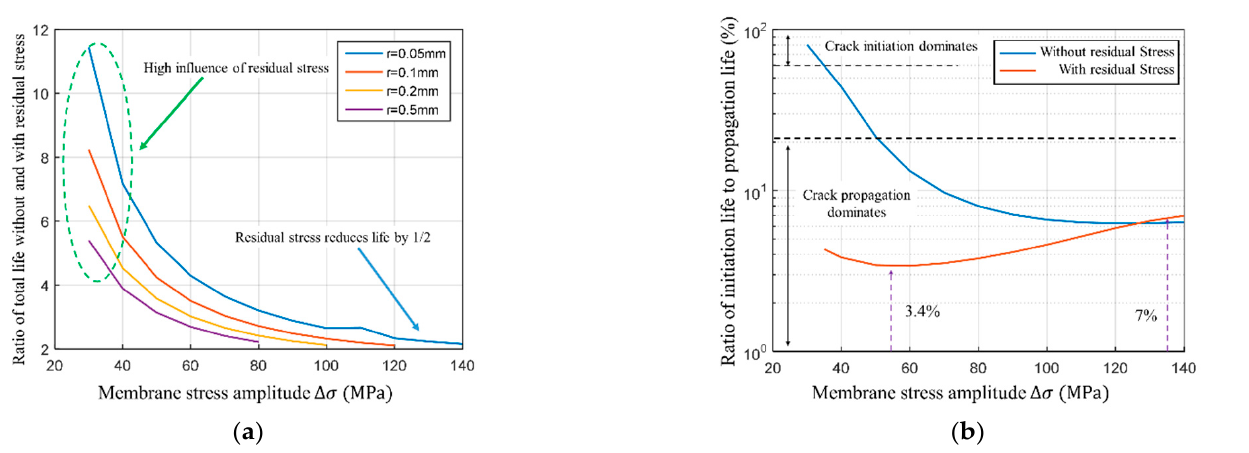
Figure 21. Effect of residual stress on total life and ratio of initiation life to propagation life. ( a ) Relationship between the degree of life reduction and membrane stress; ( b ) Relationship between ratio of initiation life to propagation life and membrane stress.